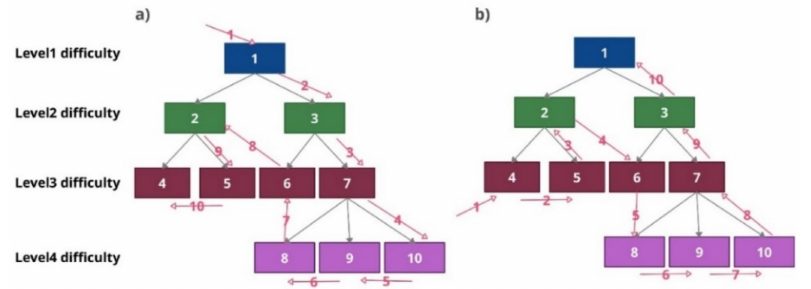
Figure 5. A transformation process: ( a ) TBCG where all a student’s answers are incorrect (tasks sequence is 1, 3, 7, 10, 9, 8, 6, 2, 5, 4); ( b ) BTCG where all a student’s answers are correct (tasks sequence is 4, 5, 2, 6, 8, 9, 10, 7, 3,